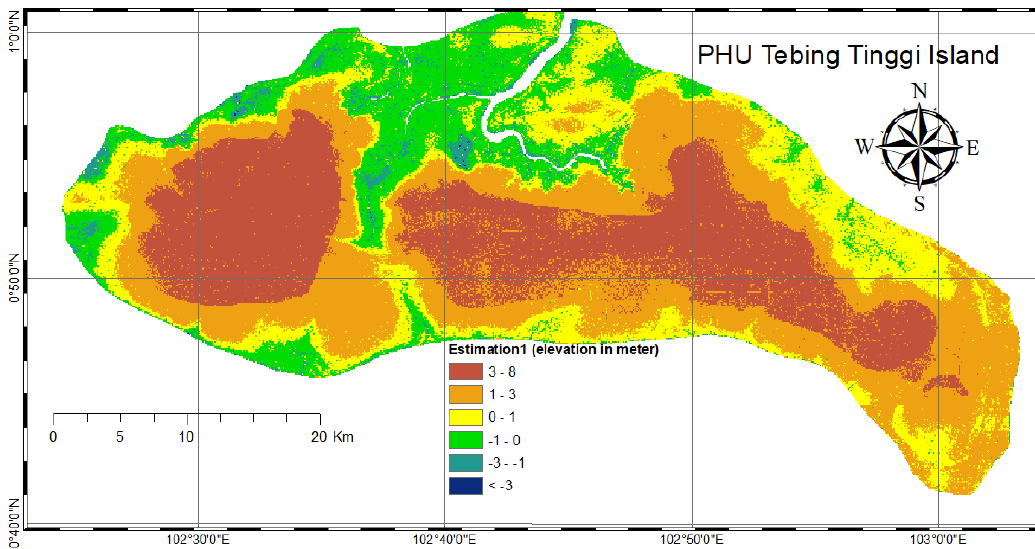
Figure 4. The condition of elevation mineral soil resulted in the estimation model by involving all covariates. Note: the elevation is above the local MSL.